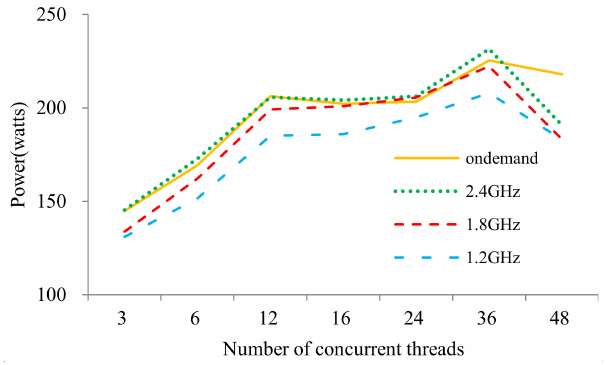
Figure 3. Power consumption of server #2 with array size = 4 GB.